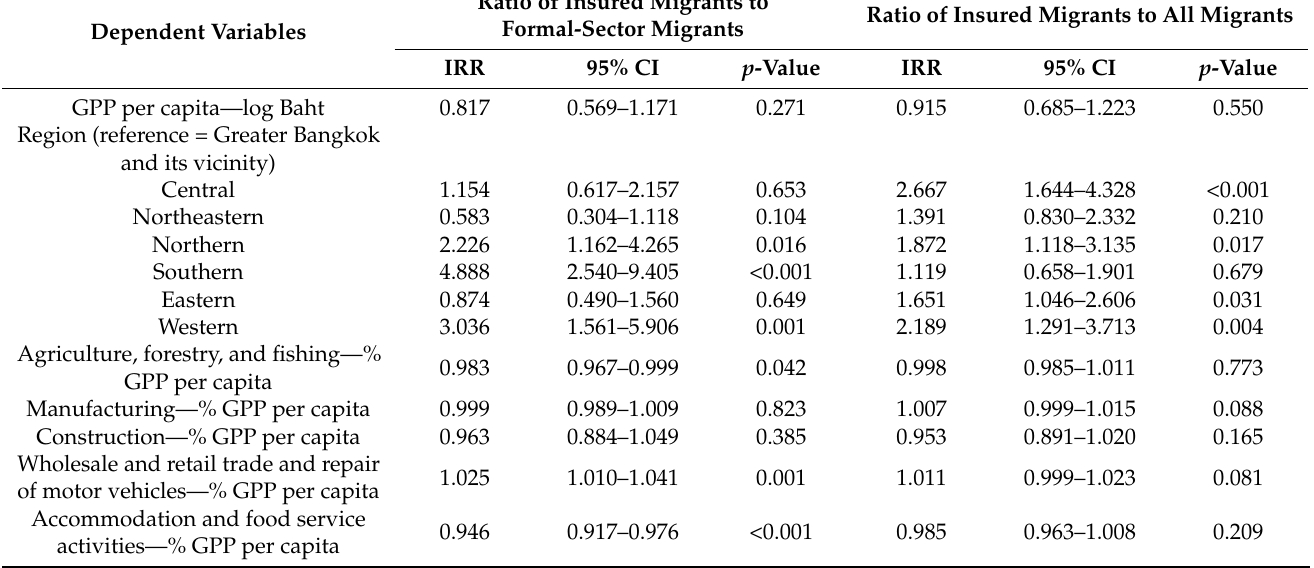
Table 3. Association between dependent variables (ratio of insured migrants to formal-sector migrants, and ratio of insured migrants to all migrants) and all predictor variables by negative binomial